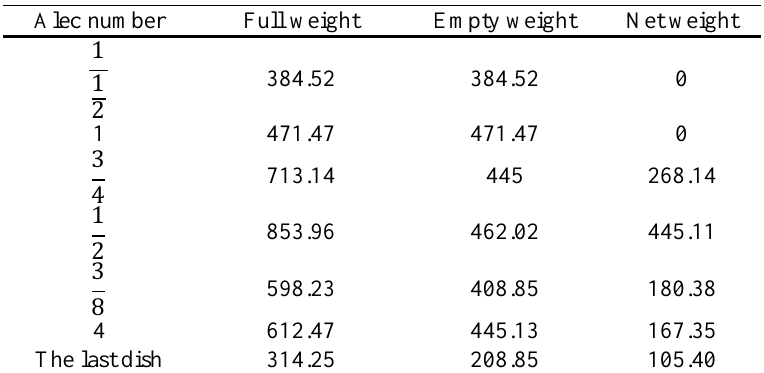
Table 2. Sand granulation table.